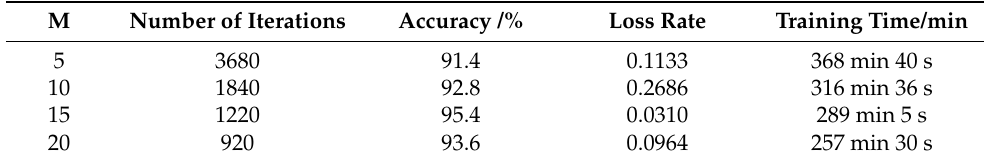
Table 5. Influence of different batches on training results.